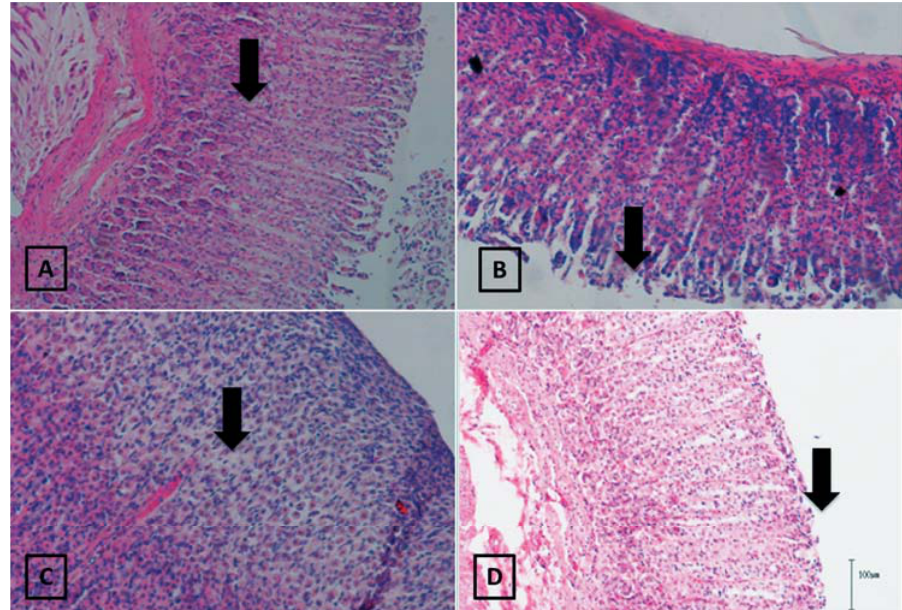
Figure 5- Histological observation. A– Group II, mucosal changes with foci of necrosis and sloughing can be observed; B– Group III, loss of the surface layer of the mucosal epithelium can be observed; C– Group IV, the (cid:83)(cid:85)(cid:72)(cid:86)(cid:72)(cid:81)(cid:70)(cid:72)(cid:3)(cid:82)(cid:73)(cid:3)(cid:76)(cid:81)(cid:192)(cid:68)(cid:80)(cid:80)(cid:68)(cid:87)(cid:82)(cid:85)(cid:92)(cid:3)(cid:76)(cid:81)(cid:191)(cid:79)(cid:87)(cid:85)(cid:68)(cid:87)(cid:72)(cid:3)(cid:68)(cid:81)(cid:71)(cid:3)(cid:72)(cid:71)(cid:72)(cid:80)(cid:68)(cid:3)(cid:80)(cid:68)(cid:92)(cid:3)(cid:69)(cid:72)(cid:3)(cid:82)(cid:69)(cid:86)(cid:72)(cid:85)(cid:89)(cid:72)(cid:71)(cid:30)(cid:3)(cid:39)(cid:177)(cid:3)(cid:42)(cid:85)(cid:82)(cid:88)(cid:83)(cid:3)(cid:57)(cid:15)(cid:3)(cid:79)(cid:82)(cid:86)(cid:86)(cid:3)(cid:82)(cid:73)(cid:3)(cid:86)(cid:88)(cid:83)(cid:72)(cid:85)(cid:191)(cid:70)(cid:76)(cid:68)(cid:79)(cid:3)(cid:72)(cid:83)(cid:76)(cid:87)(cid:75)(cid:72)(cid:79)(cid:76)(cid:68)(cid:79)(cid:3)(cid:79)(cid:68)(cid:92)(cid:72)(cid:85)(cid:3)(cid:82)(cid:73)(cid:3)